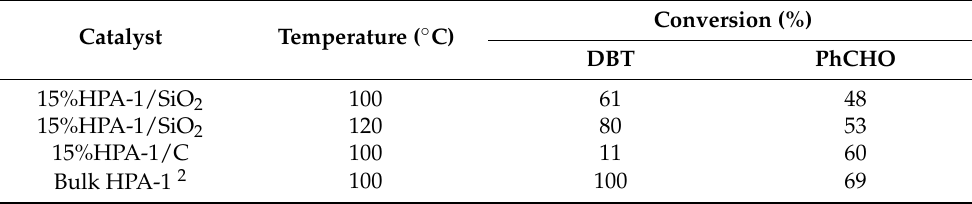
Table 3. Aerobic co-oxidation of DBT and PhCHO catalyzed by supported HPA-1 1 . Catalyst